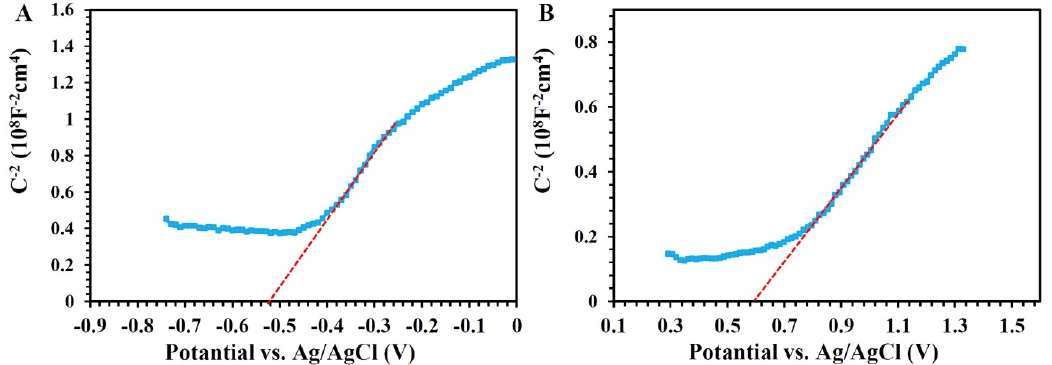
Fig. 5. Mott-Schottky measurements for (A) TiO